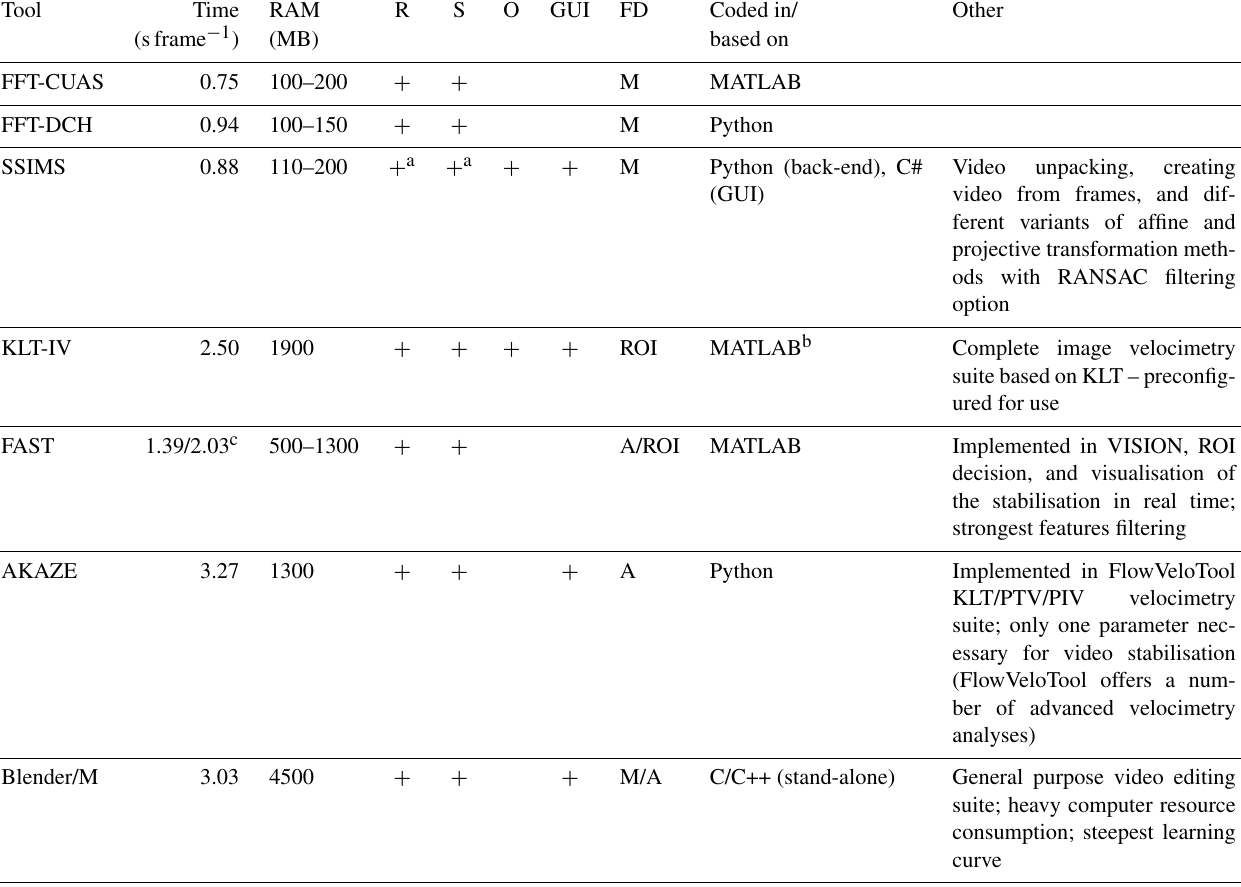
Table 6. Summary of capabilities, complexity, and limitations of different stabilisation tools, based on the Kolubara case study.